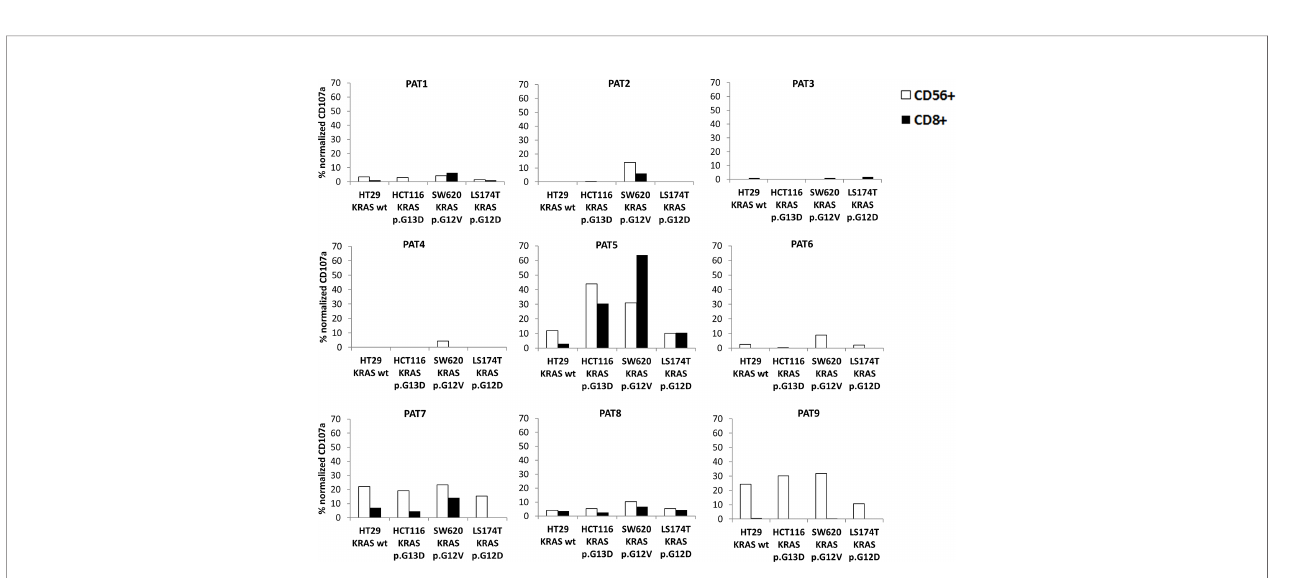
FIGURE 5 | Cytotoxicity of peripheral lymphocytes from oligometastatic patients (PAT1-9) against different CRC target cells was evaluated through CD107a externalization (see Methods ) on CD3 + /CD8 + from NK-depleted PBMCs (black column) and CD3 − /CD56 + NK cells (white column) (representative results of three experiments). Targets were HT29 (KRAS wild-type), HCT116 (KRAS p.G13D), SW620 (KRAS p.G12V), and LS174T (KRAS p.G12D). Normalized CD107a was the percentage of CD107a + cells subtracted from spontaneous degranulation/PMA-IONO-induced degranulation (positive